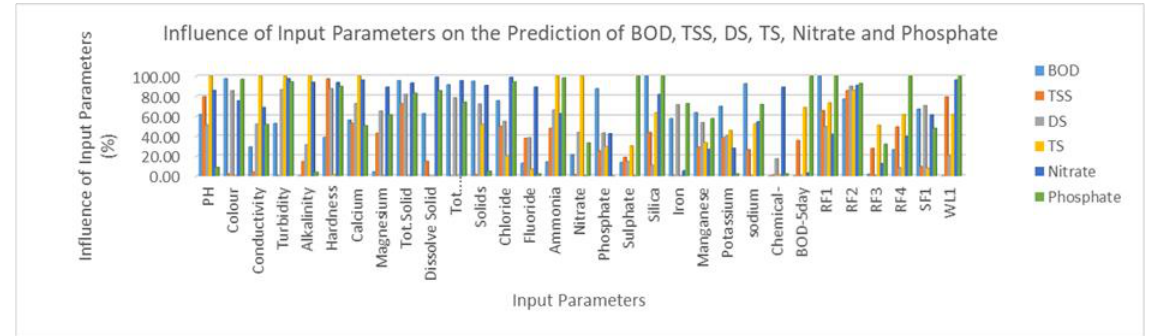
Figure 6. Influence of the input parameters on the prediction of the respective water quality parameters.